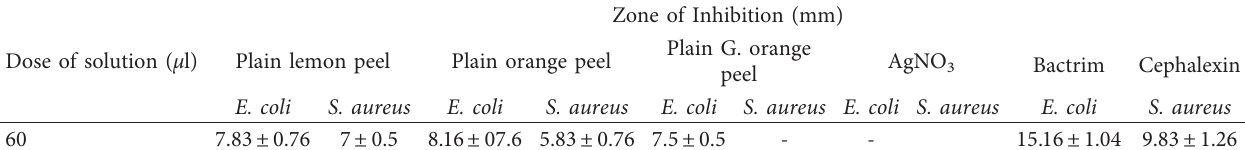
Table 2: Effect of plain peel extracts (control) and effect of standard antibiotics on the growth of bacterial species. Dose of solution ( μ